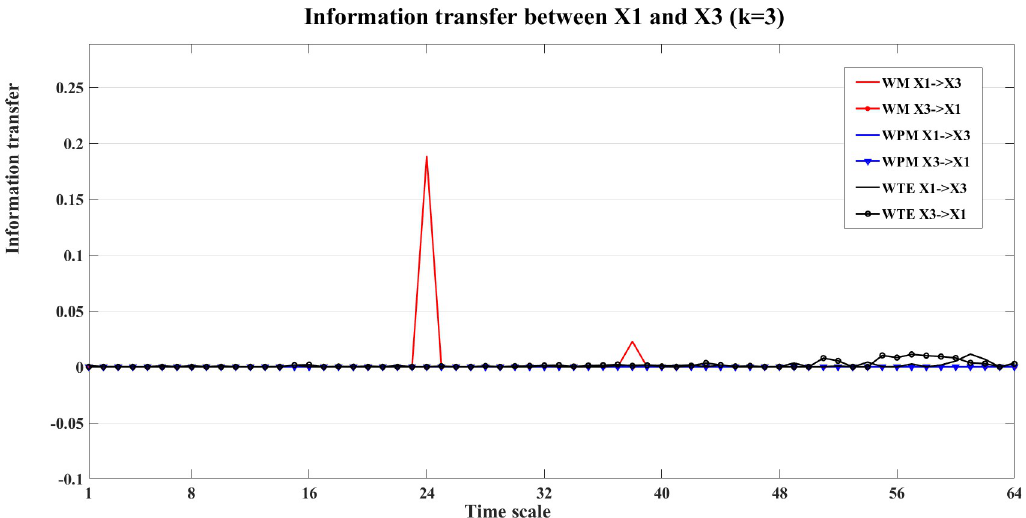
Fig 18. Information transfer between X1 and X3. In this figure, the bias corrected WM (red), WPM (blue) and WTE (black) information transfer between X1 and X3 are plotted at different time scales s X1 and X3, only WM identifies the indirect direction of interaction from X1- > X3, WPM is a direct measure that presents zero information transfer between X1 and X3. WTE presents almost zero information transfer between X1 and X3 with slightly higher X3- > X1 than X1- >